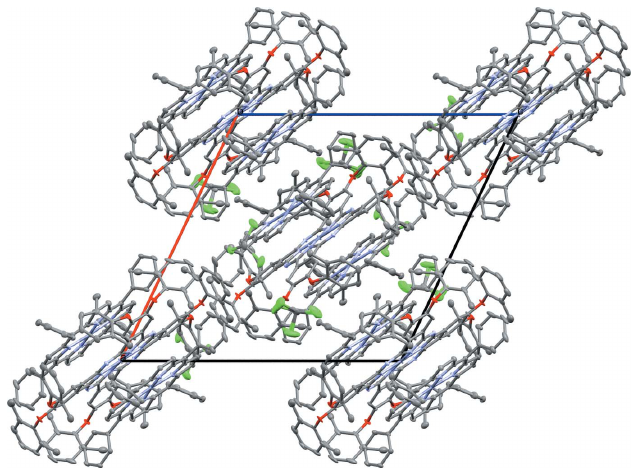
Figure 2 A view along the b axis of the crystal, showing the packing of the title compound.